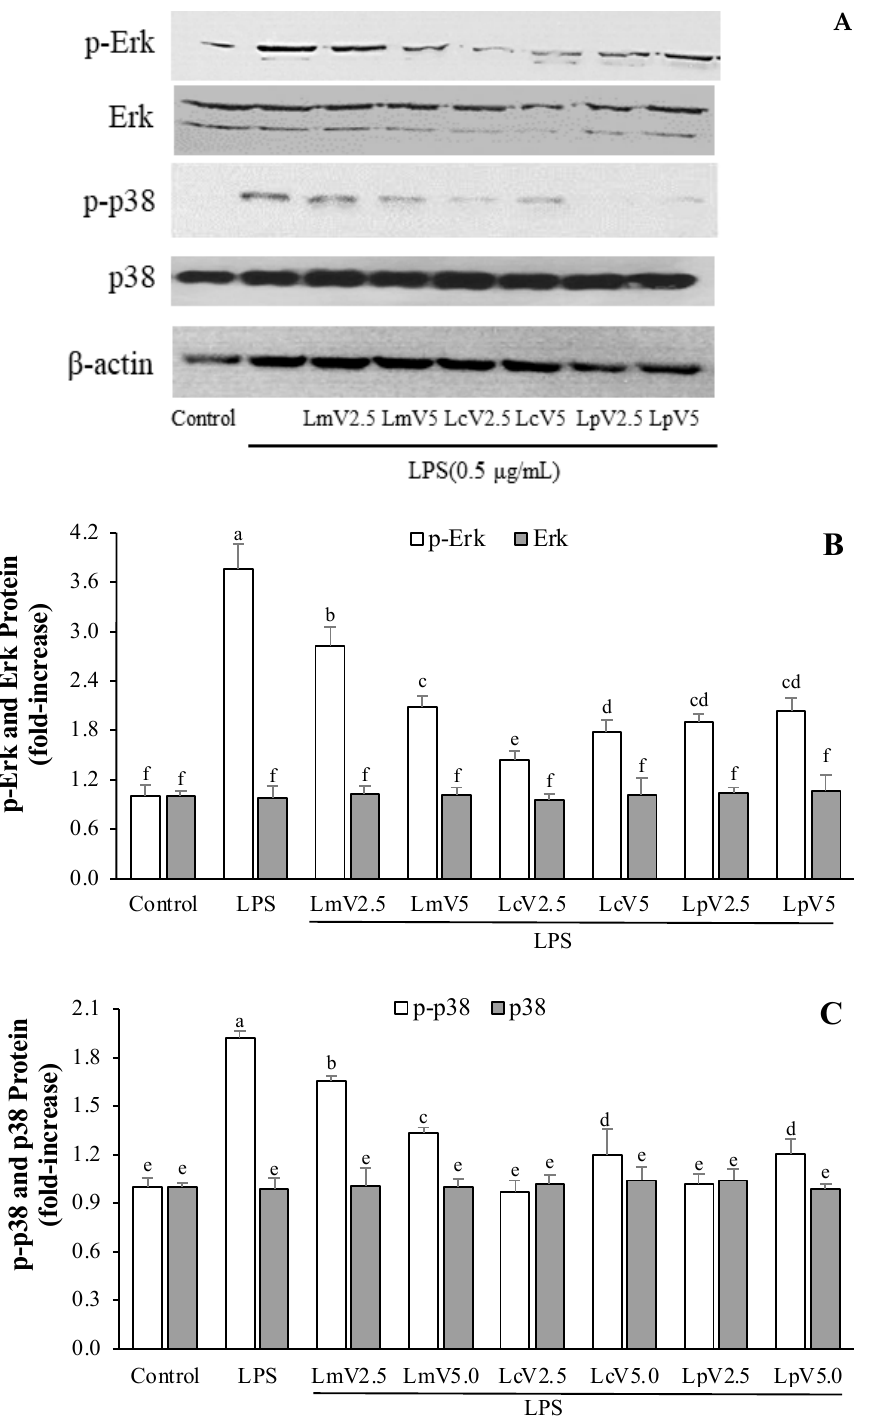
Figure 7. Effect of Le. mesenteroides, Ll. curvatus, or Lp. plantarum -derived ECVs (LmV, LcV, or LpV) on LPS-induced phosphorylation of Erk and p38 in microglia ( A – C ). The cells were pretreated with the LmV, LcV, or LpV (2.5 and 5.0 µ g/mL) for 2 h, followed by treatment with the LPS (0.5 µ g/mL) for 30 min. The Erk, p-Erk, p38, and p-p38 levels in each sample were normalized to the β -actin levels. Control and LPS were control cells (LPS and sample-untreated cells) and LPS group cells (cell treated with the LPS only), respectively. The phosphorylation of Erk and p38 was abbreviated by p-Erk and p-p38. Values are expressed as the mean ± SD ( n = 4) and those followed by different letters (a–f) within a property are significantly different ( p < 0.05) according to Duncan’s multiple range test.